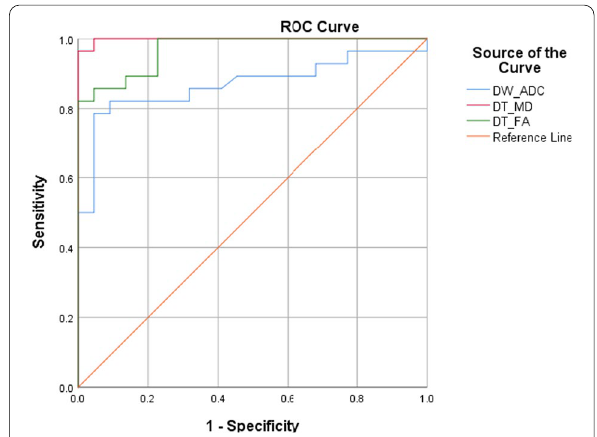
Fig. 1 ROC curve of DT‑FA, MD and DW‑ADC in differentiating myometrial invasion